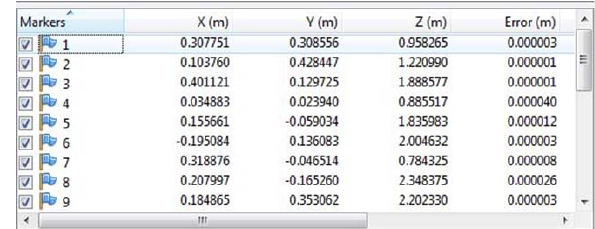
Figure 6. Re-projection errors on targets of the non-optimised model in Agisoft Photoscan.